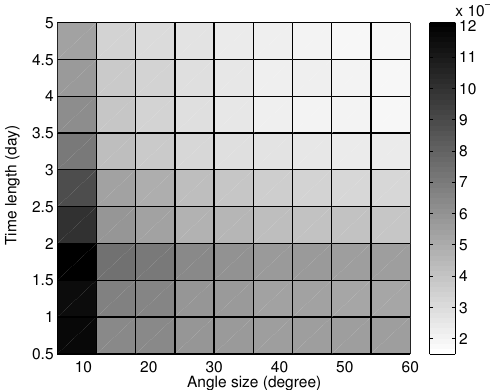
Figure 16. Variance of the estimated optimal correction factor, ˆ η , for different combinations of angle size of LA and the time length for averaging in calculating